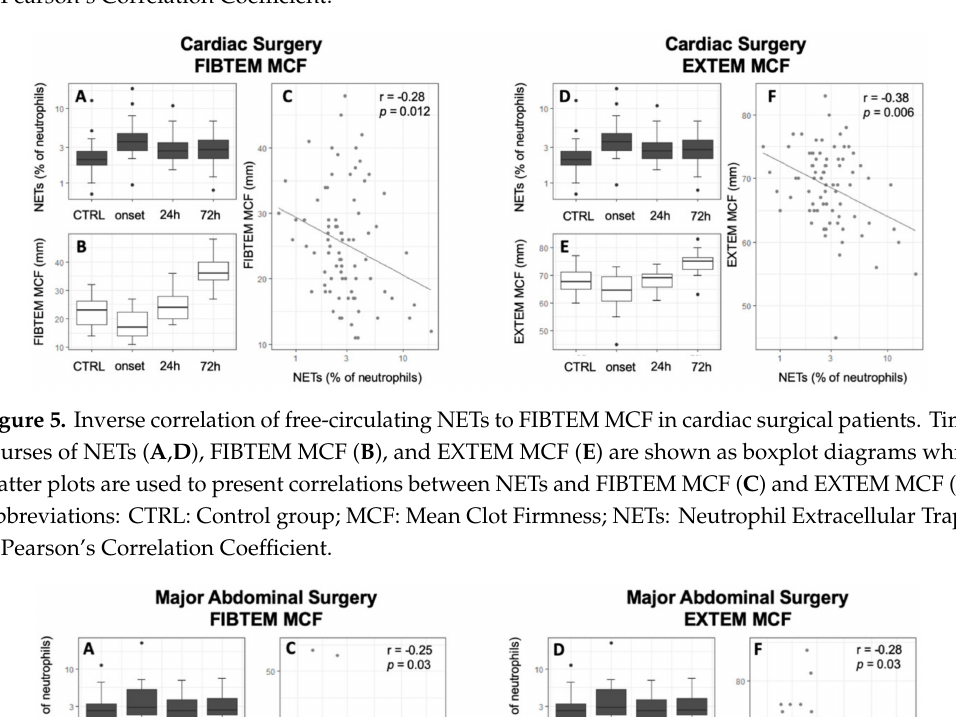
Figure 4. Positive correlation of free-circulating NETs to FIBTEM MCF in septic shock patients. Time courses of NETs ( A , D ), FIBTEM MCF ( B ), and EXTEM MCF ( E ) are shown as boxplot diagrams while scatter plots are uses to present correlations between NETs and FIBTEM MCF ( C ) and EXTEM MCF ( F ). Abbreviations: CTRL: Control group; MCF: Mean Clot Firmness; NETs: Neutrophil Extracellular Traps; r : Pearson’s Correlation Coe ffi cient.